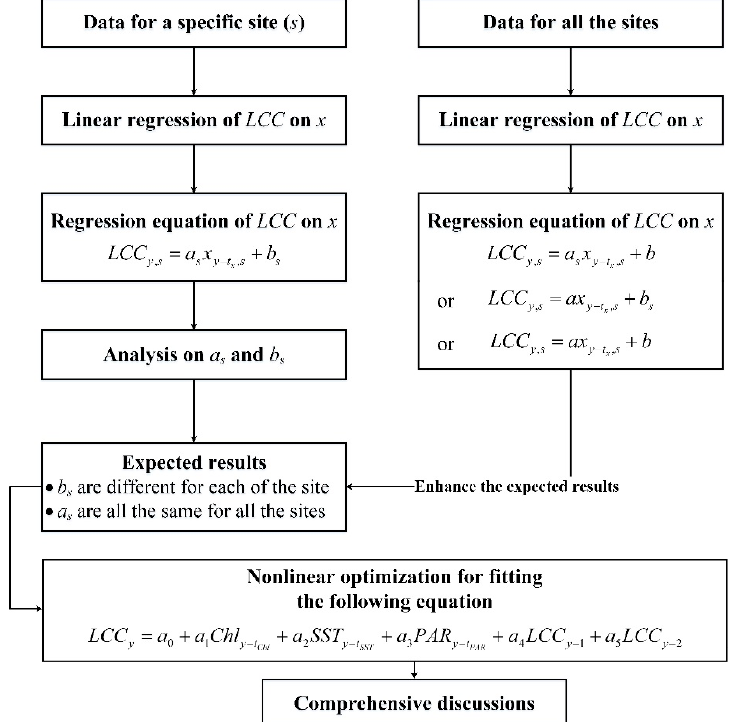
Figure 3. Program for the analysis on the changes of the LCCs associated with environmental parameters. (a. We expected to obtain the result that a s are all the same for different study sites but b s are different for each of the study sites by the linear regressions; b. if the expected result was obtained, a nonlinear optimization would be further utilized to form a model described by using the equation).